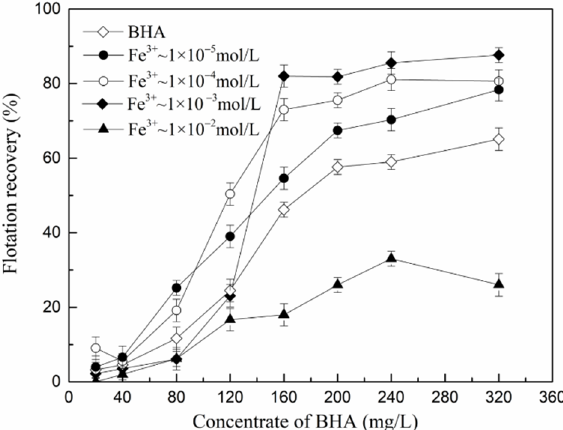
Figure 4. Recoveries of scheelite by the Fe-BHA with different BHA/FeCl 3 ratios as a function of BHA concentration.